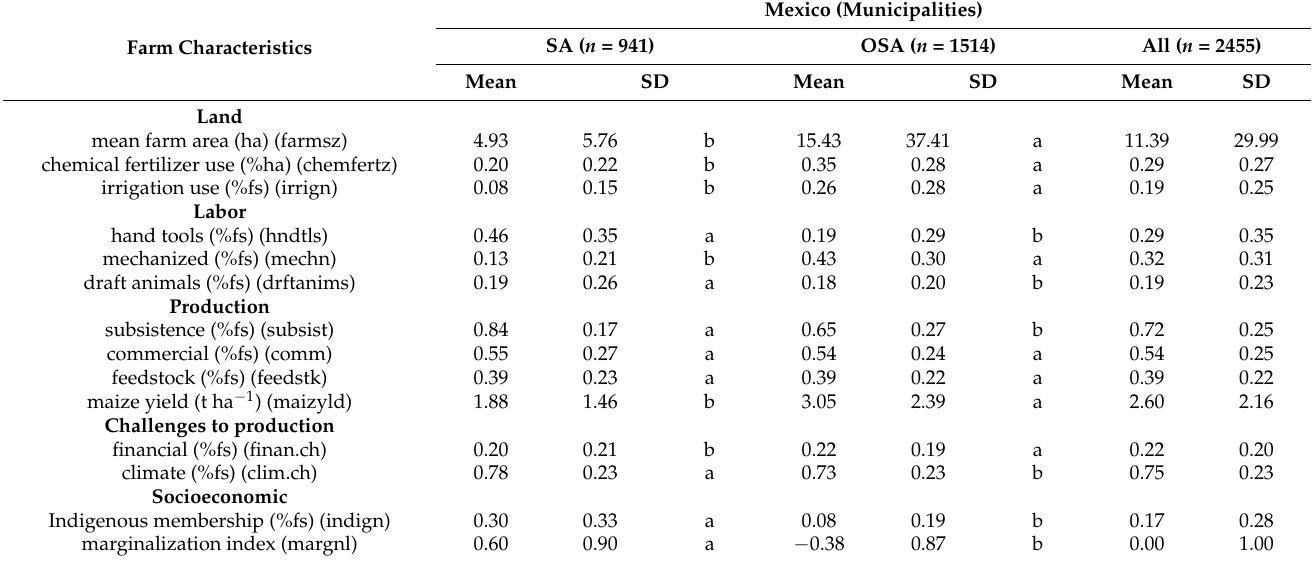
Table 1. Farm characteristics of municipalities in the study area (SA) and outside the study area (OSA) in hectares (ha), percent cultivated area (%ha), percent of all farms (%fs), and yield (t ha − 1 ). Abbreviations are used in figures/tables that follow. Letters (a,b) show significant difference comparisons between the groups using t-tests for parametric data, Mann–Whitney’s tests for non-parametric data, and Chi-square tests for proportions data ( α = 0.05).